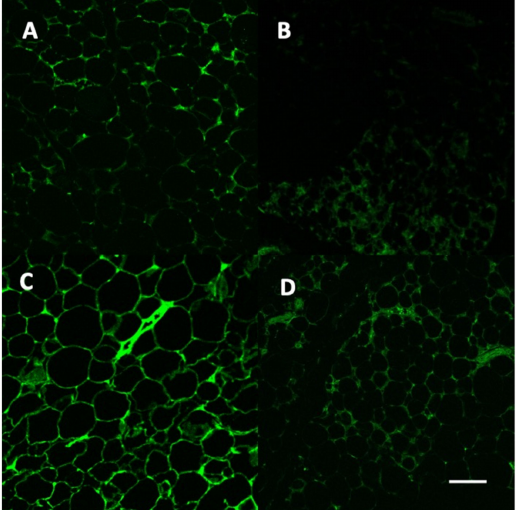
Figure 6. Representative images of adipose tissue from animals in the four groups using a confocal microscope; 20 × objective. Panel ( A ): Citrate + GFPvv; Panel ( B ): STZ + GFPvv, Panel ( C ): Citrate + Lepvv; Panel ( D ): STZ + Lepvv. Green fluorescent protein indicates the presence of GFPvv in panels ( A , B ) and Lepvv in panels ( C , D ). Scale bar represents 200 µ